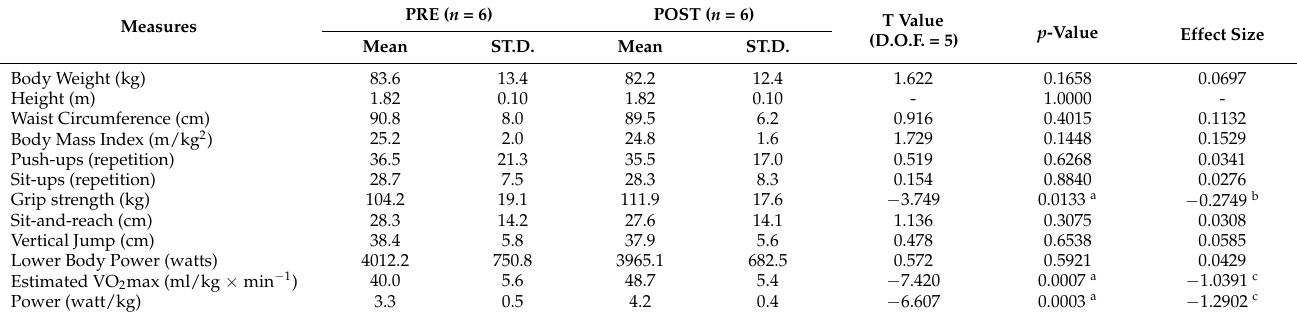
(D.O.F. = 5) p -Value Effect Size Mean ST.D.